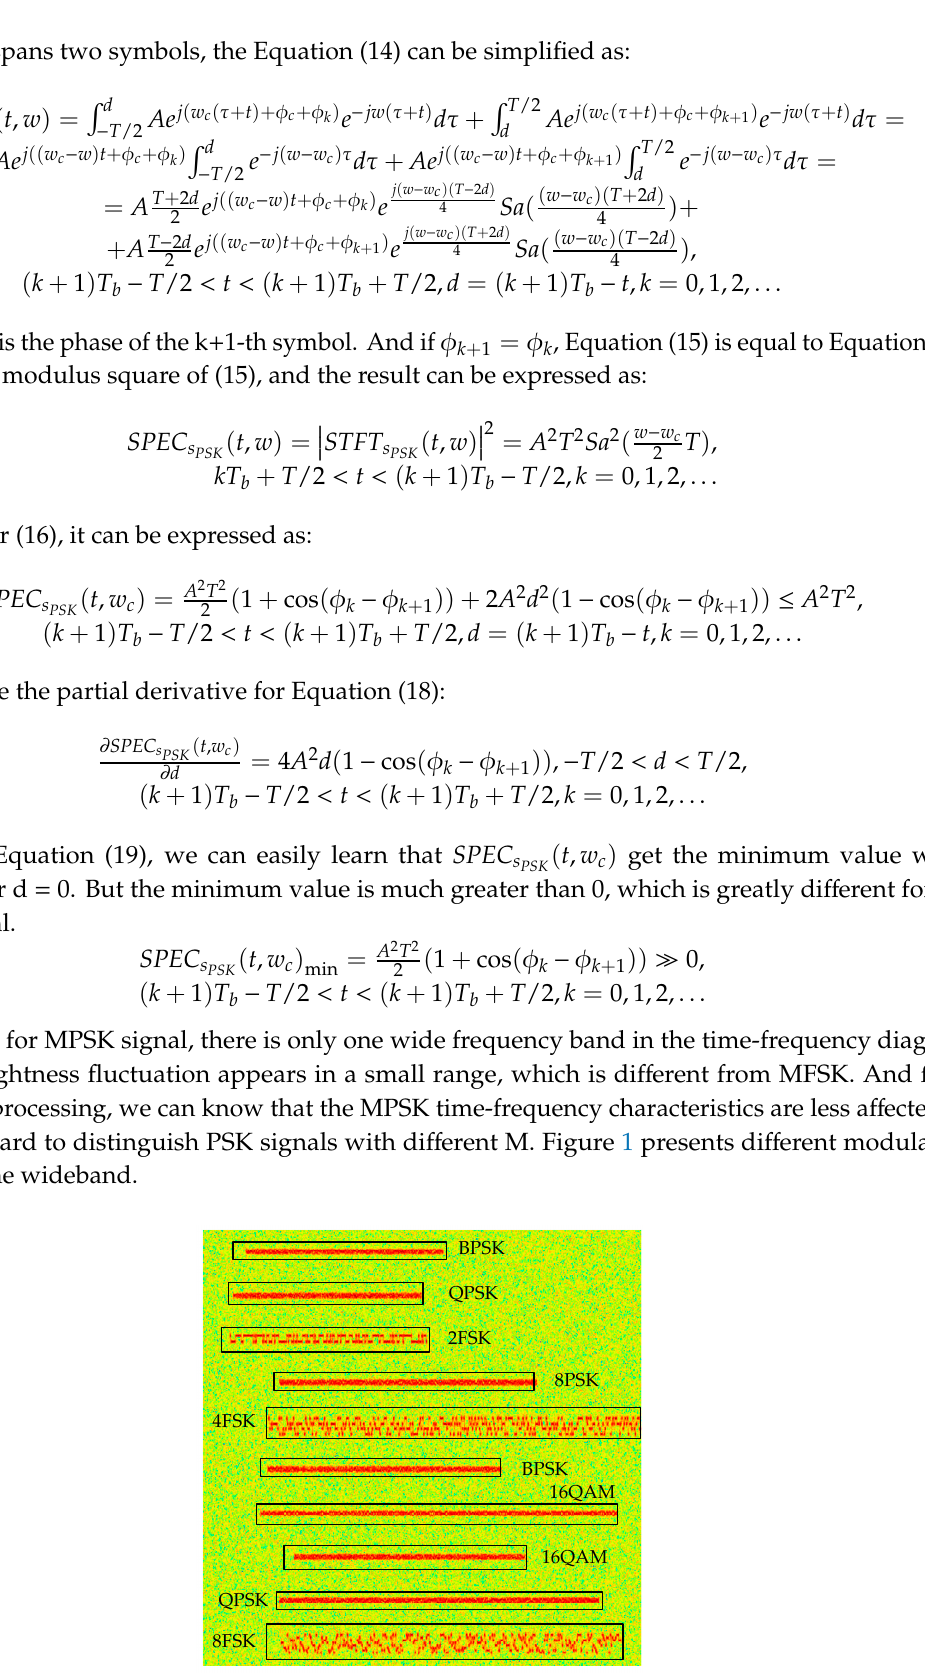
( h ) Figure 2. The eye diagram and vector diagram of different modulation signals in 15dB ( a ) BPSK; ( b ) QPSK; ( c ) OQPSK; ( d ) 8PSK; ( e ) 16QAM; ( f ) 16APSK; ( g ) 32APSK; ( h ) 64QAM.